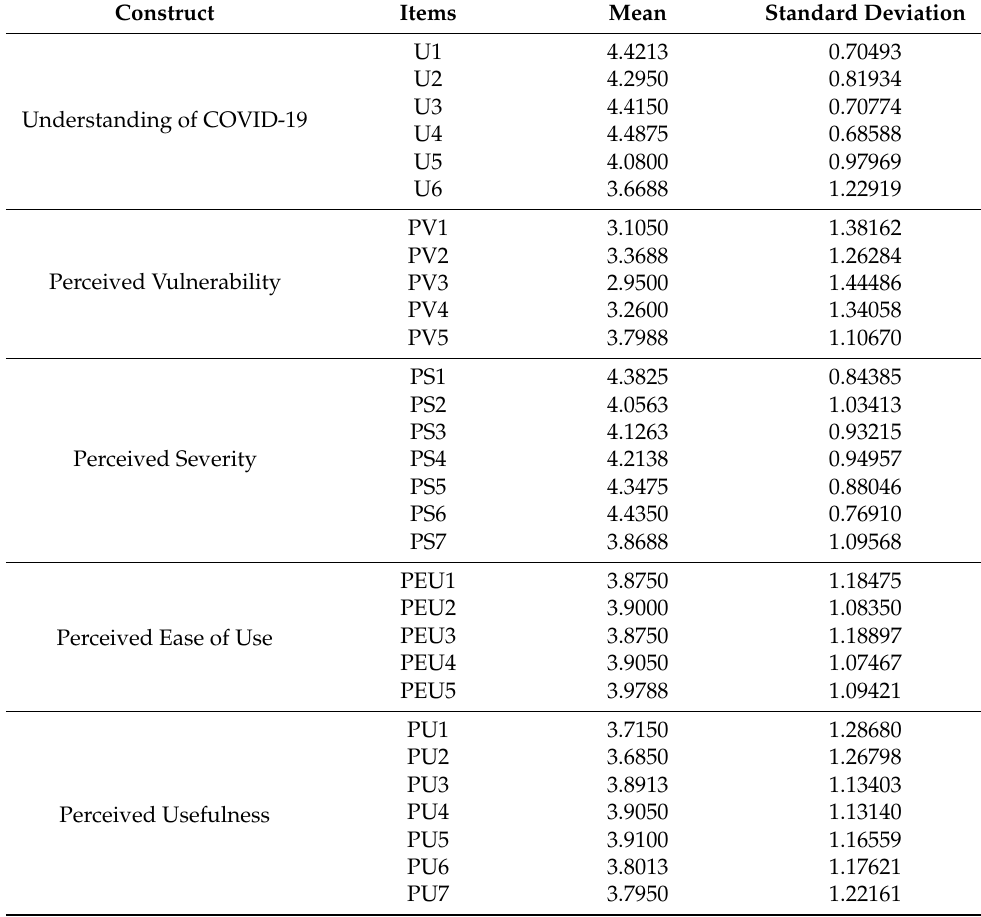
Table 3. Descriptive Statistics of the